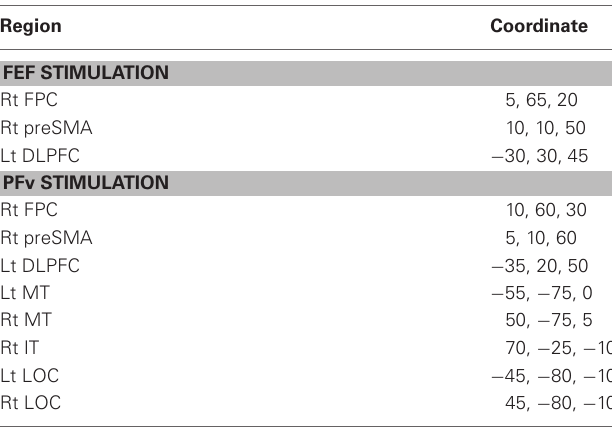
Table 2 | Region and MNI coordinate of the cortical source density peak of